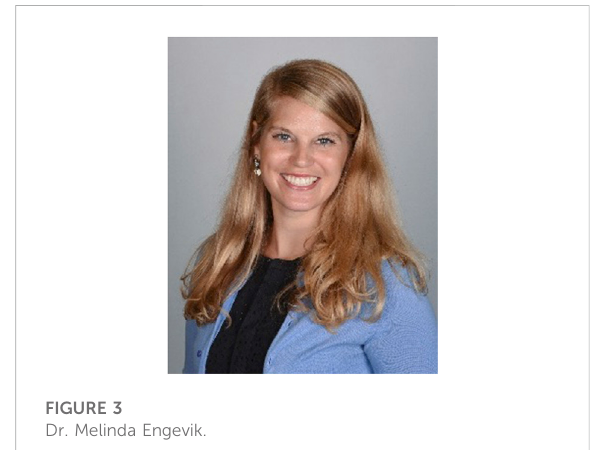
FIGURE 3 Dr. Melinda Engevik.